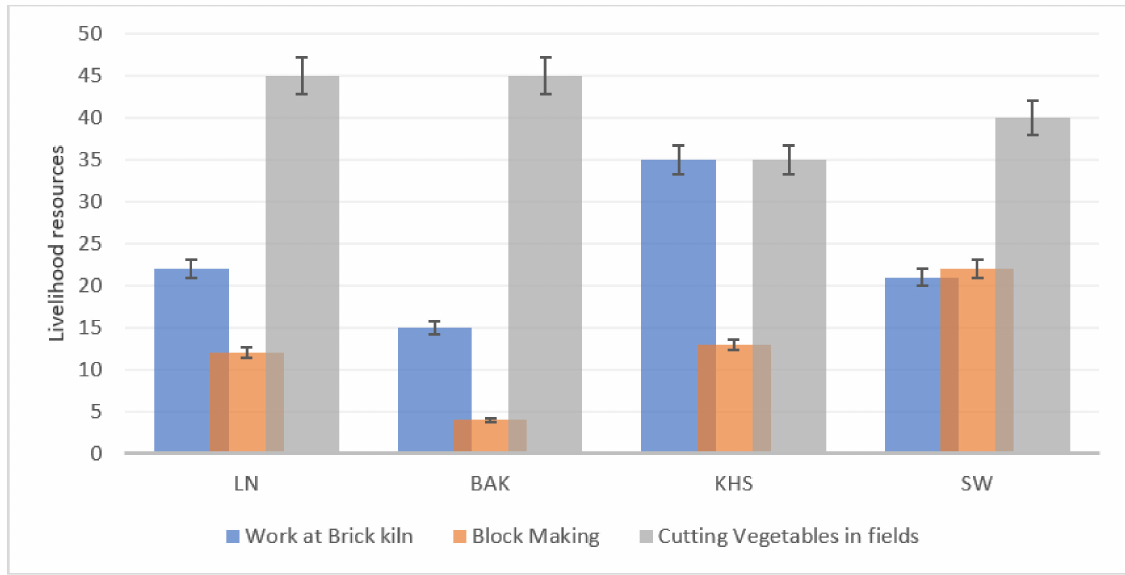
Figure 12. Major livelihood sources in flood-affected areas of district Layyah.